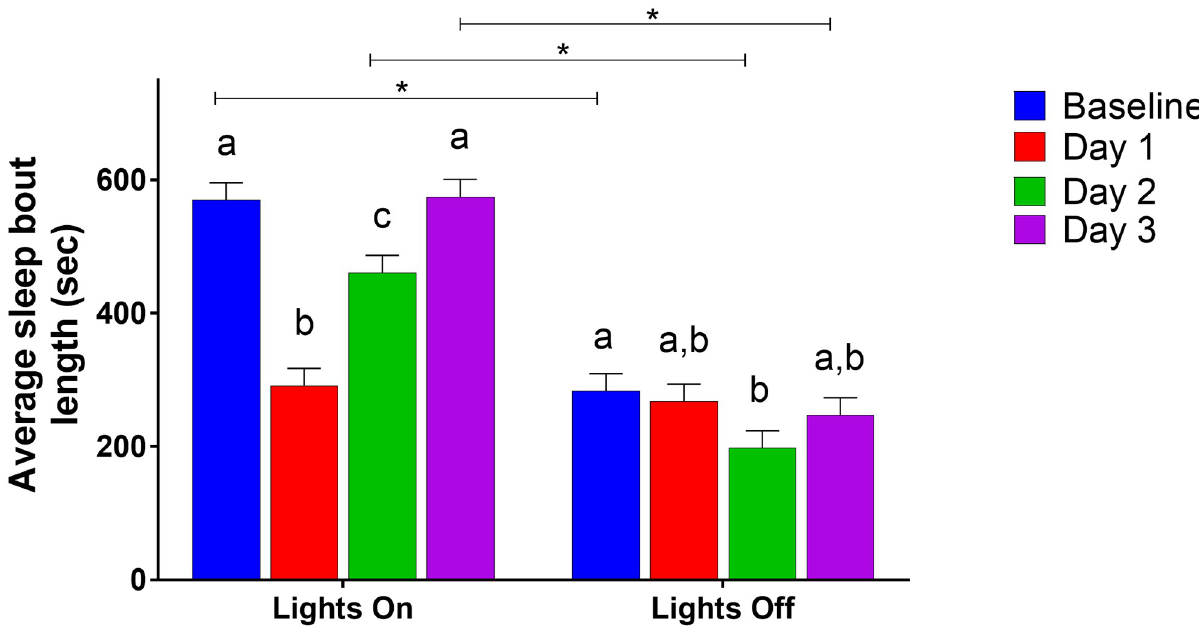
Fig 4. Average sleep bout length by lights on/off and day of experiment. Different letters indicate significant (Tukey, P < 0.05) differences within categories, bars indicate differences between categories. Data presented are LSM and SE.